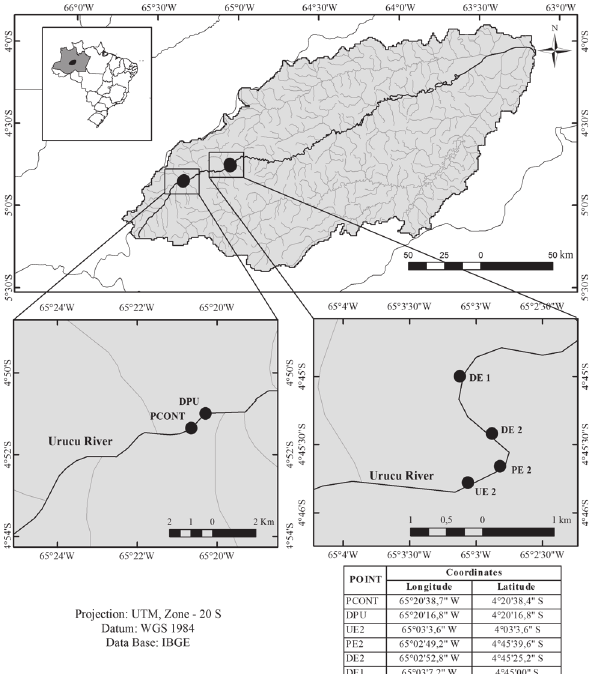
Figure 1. Study area showing the sampling areas and sampling